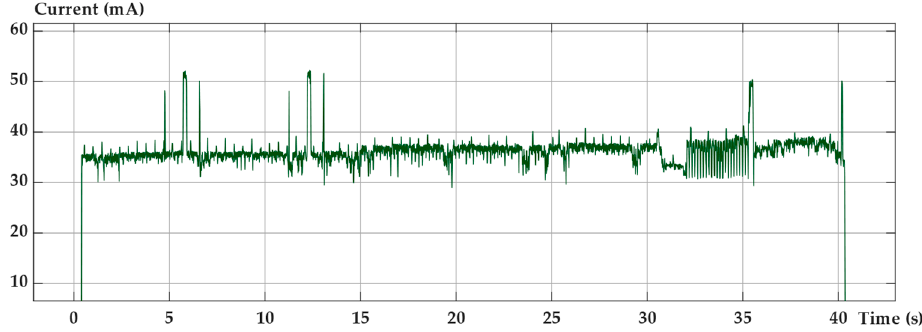
Figure 7. Structural node battery current absorption measured during an activity